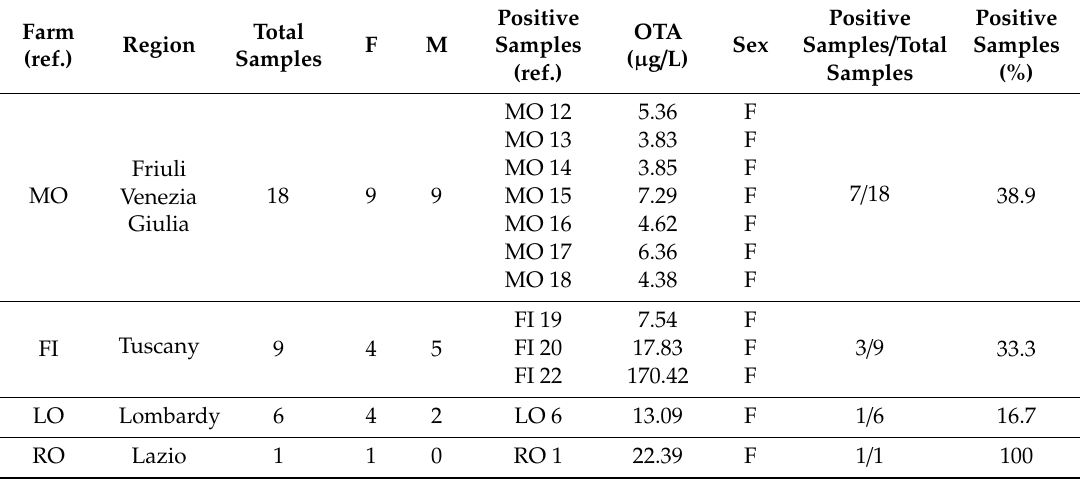
Table 4. Samples of bile tested positive for